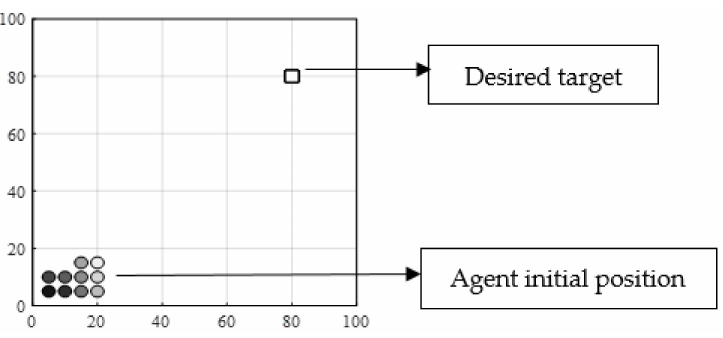
Figure 6. Agent 2D workspace (initial state position and desired